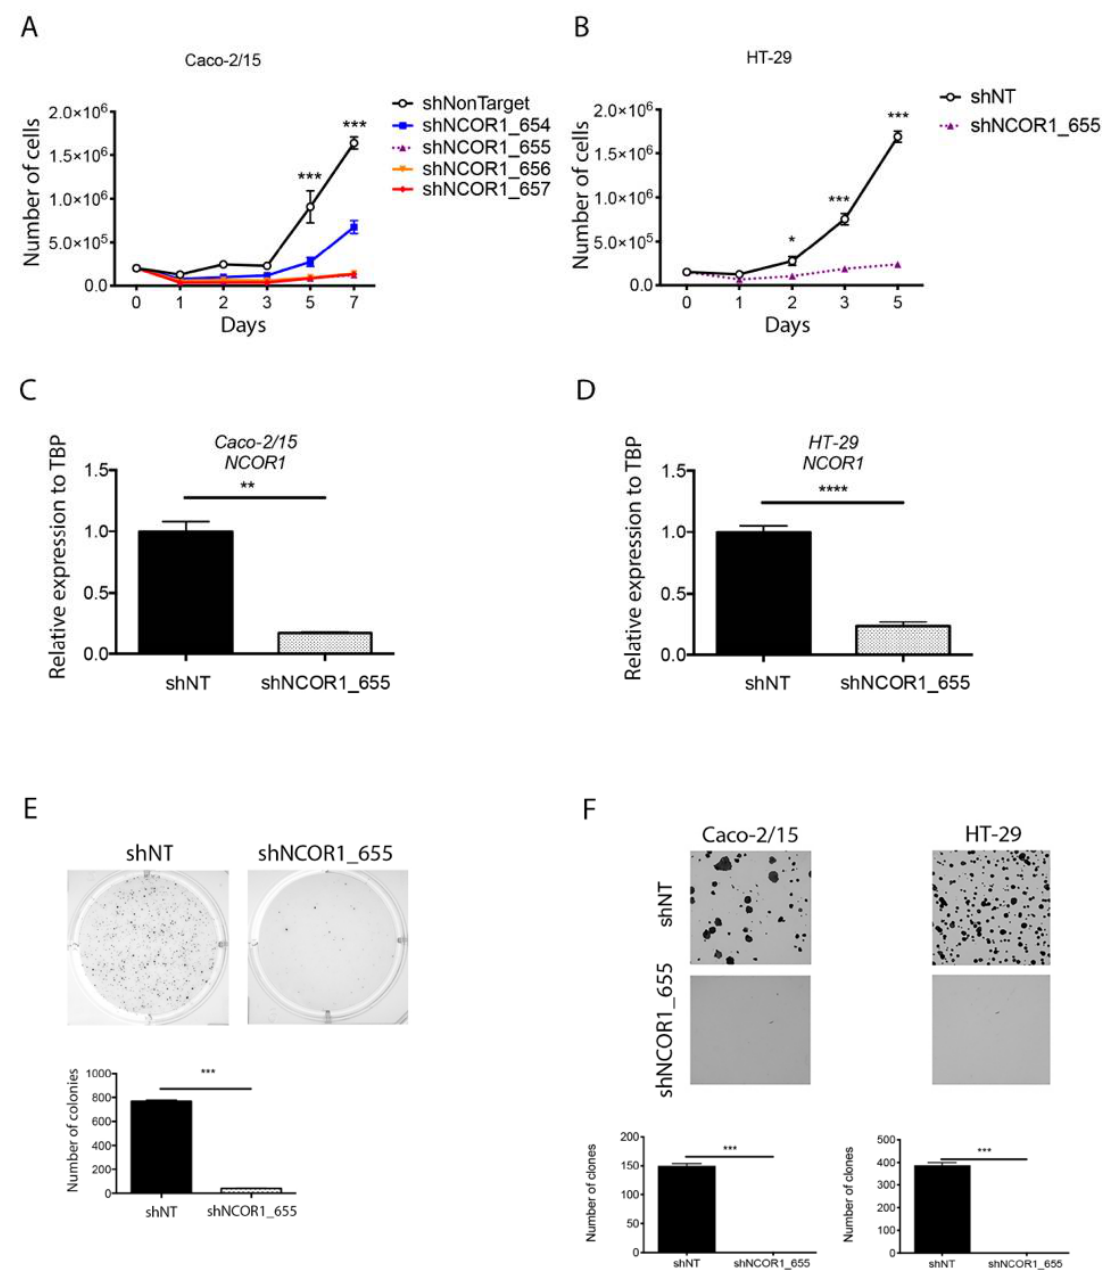
Figure 2. NCOR1 downregulation leads to slower proliferation with reduced tumorigenic potential of CRC cells ex vivo. ( A ) Validation of shRNAs directed against NCOR1 by qRT-PCR analysis. NCOR1 transcript expression was measured from total RNA isolated 7 days after infection from Caco-2/15 cells ( n = 3; means ± SEM) and ( B ) HT-29 cells ( n = 4; means ± SEM). TBP gene transcript levels were used as reference. Student’s t- tests were used to measure the significance of the results (* p < 0.05; *** p < 0.001). ( C ) Cell counts made 1, 2, 3, 5, and 7 days after seeding a fixed number of Caco-2/15 (** p < 0.01) and ( D ) HT-29 cells ( n = 3; means ± SEM). Two-way ANOVA tests and a multiple comparison test by Bonferroni method were used to measure the significance of the results (**** p < 0.0001). ( E ) Photographs representative of an independent anchoring growth assay (soft agarose) in HT-29 cells. Image J software was used to count the number of colonies present in each of the conditions ( n = 3; means ± SEM). Student’s t -test was used to measure significance (*** p < 0.001). ( F ) Clone formation assays performed in Caco-2/15 and HT-29 cells. Colonies were stained with crystal violet 14 days after seeding 1000 cells of each population. Image J software was used to count the number of clones present in each of the conditions ( n = 3; means ± SEM). Student’s t -test was used to measure significance (*** p < 0.001).